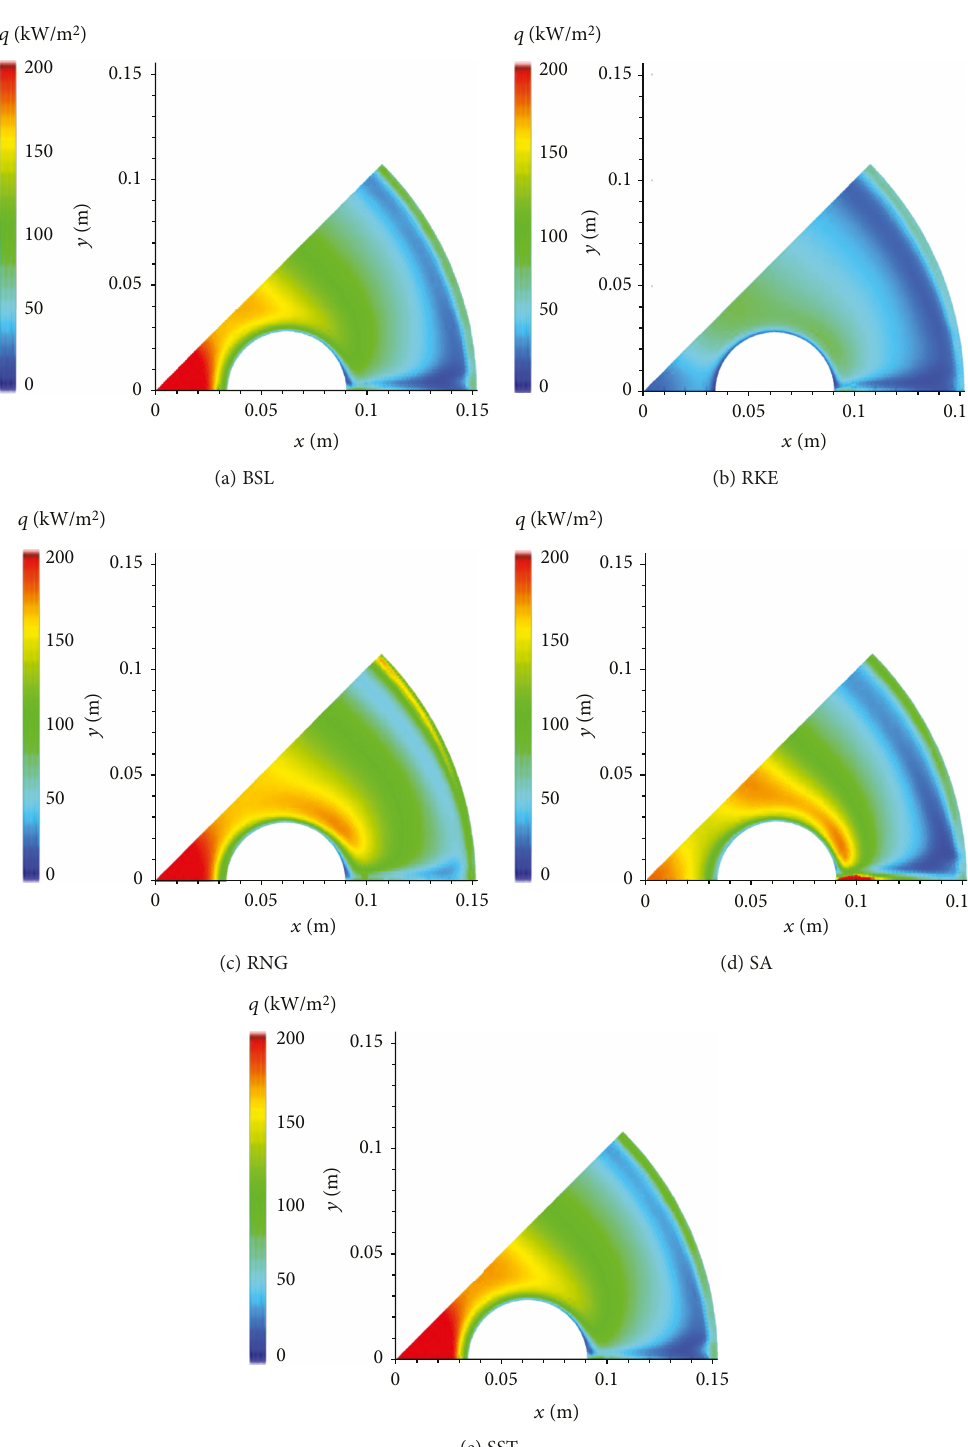
Figure 12: Contours of base heat fl ux for various turbulence